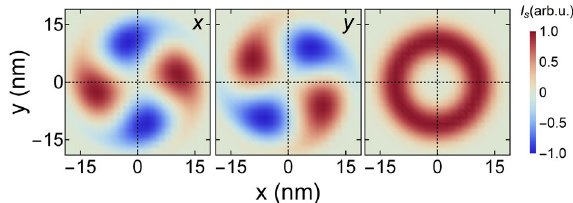
Fig. 6 Cross section of the ISHE signal. The spin accumulation due to a twisted magnon wave packet with ℓ = 2 and left-handed (clockwise) chirality is calculated according to the ISHE via (cid:5) n ´ ∂ I s t n . The three panels display the different components of the induced spin-current showing that only the z -component delivers a non-zero value after integration over the whole cross section. The staggered magnetization is obtained from full- numerical spin dynamics simulations.